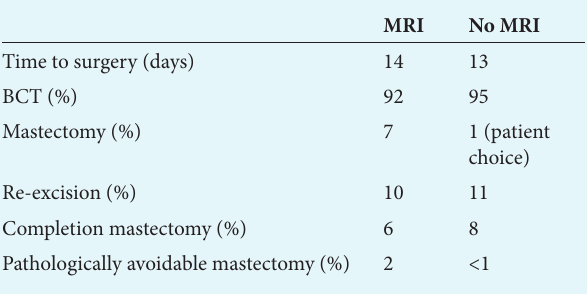
Table 3. Outcome from the COMICE trial: results adapted